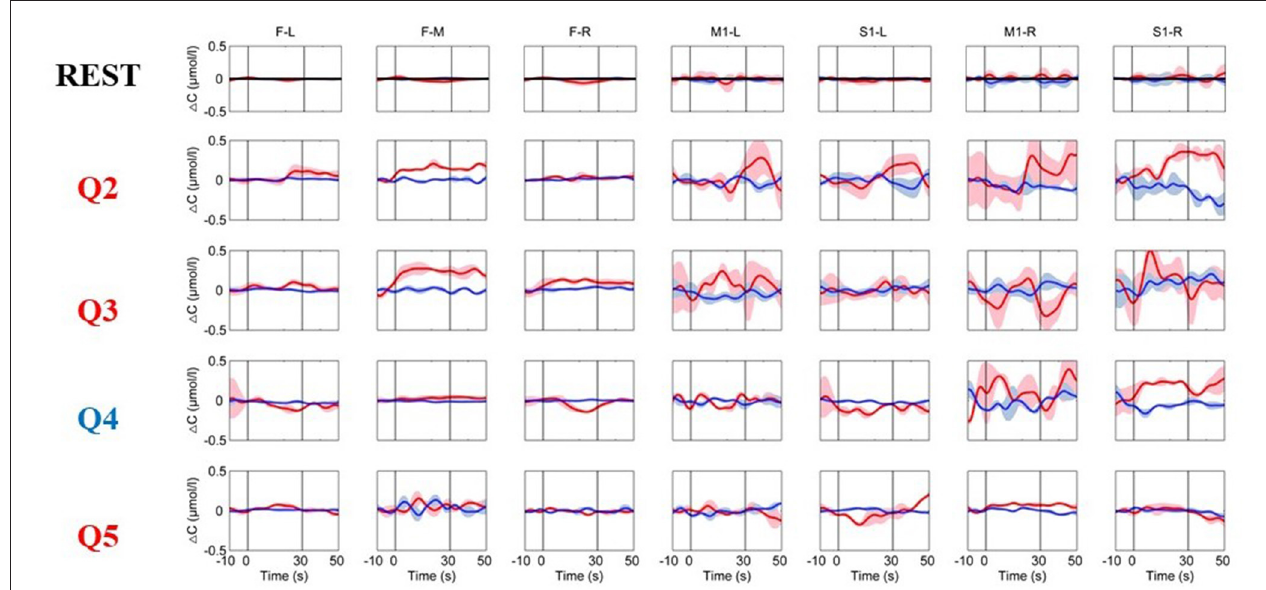
FIGURE 5 | The time courses of changes in HbO and HbR concentrations were obtained from an MCS patient (Patient 3). The resting-state time course labeled “REST” refers to data acquired without MI activation and is illustrated as a reference for comparison with the question periods. Q2–Q5 represent the hemodynamic responses for different questions Q2–Q5. The red numbers represent the ground-truth “yes” questions, whereas the blue numbers represent the ground-truth “no” questions. The red and blue lines represent HbO and HbR, respectively. The stimulus duration is indicated by the space between the two gray